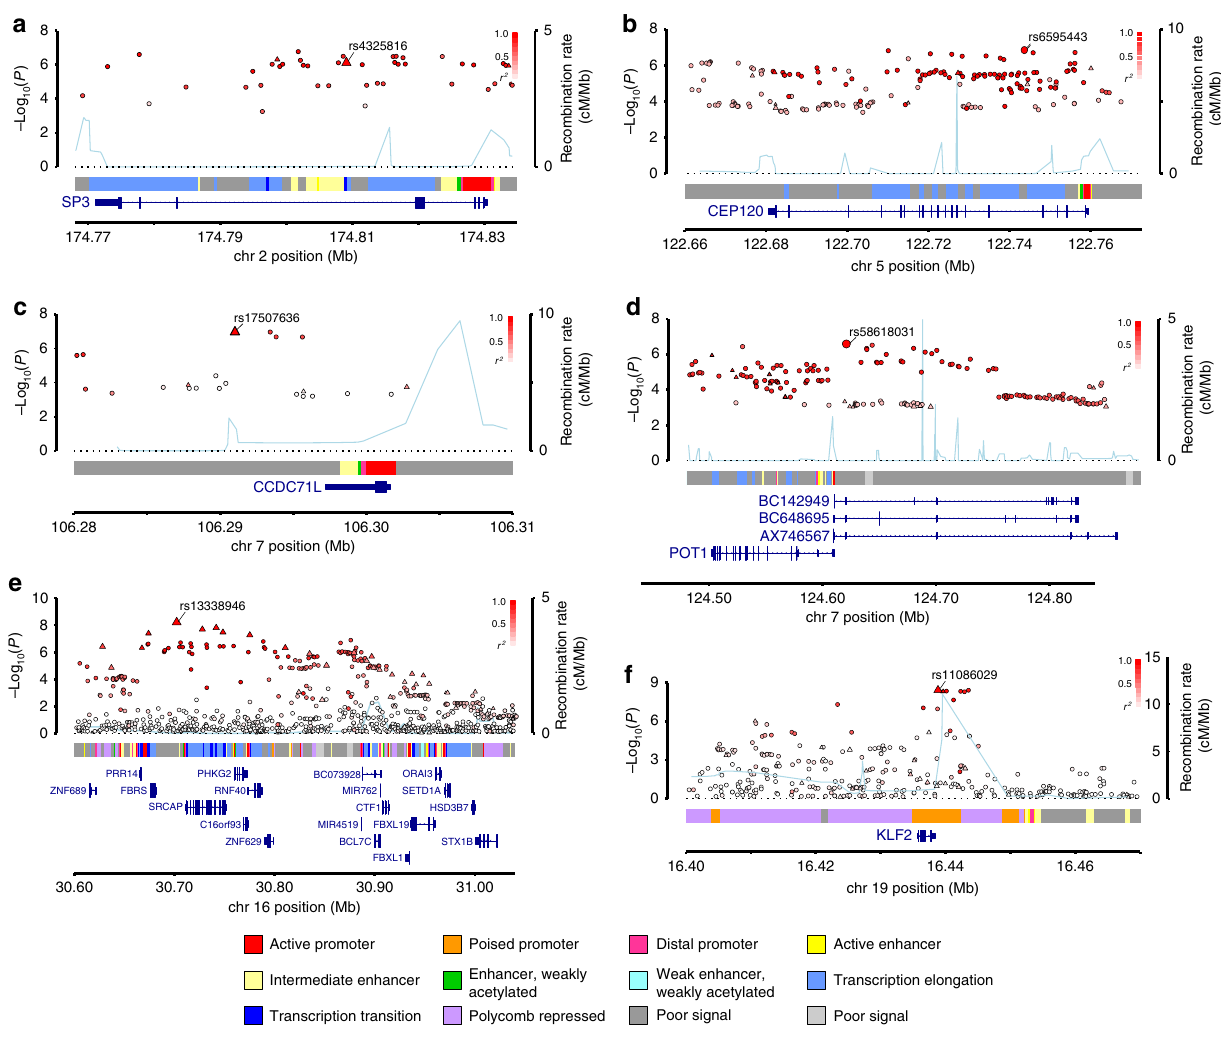
Fig. 2 Regional plots of the six new risk loci. Regional plots of loci a 2q31.1, b 5q23.2, c 7q22.3, d 7q31.33, e 16p11.2 and f 19p13.11. Plots show results of the meta-analysis for both genotyped (triangles) and imputed (circles) single-nucleotide polymorphisms (SNPs) and recombination rates. − log 10 ( P) ( y axes) of the SNPs are shown according to their chromosomal positions ( x axes). The sentinel SNP in each combined analysis is shown as a large circle or triangle and is labelled by its rsID. The colour intensity of each symbol re fl ects the extent of LD with the top SNP, white ( r 2 = 0) through to dark red ( r 2 = 1.0). Genetic recombination rates, estimated using 1000 Genomes Project samples, are shown with a light blue line. Physical positions are based on NCBI build 37 of the human genome. Also shown are the relative positions of genes and transcripts mapping to the region of association. Genes have been redrawn to show their relative positions; therefore maps are not to physical scale. The middle track represents the chromatin-state segmentation track